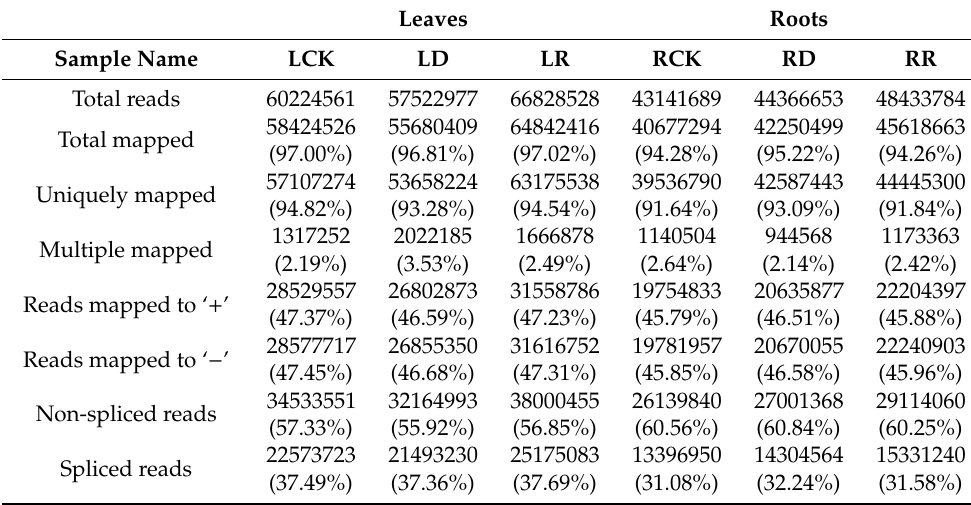
Table 1. Number of assembled reads sequenced and mapped to the Setaria italica genome. Leaves Roots